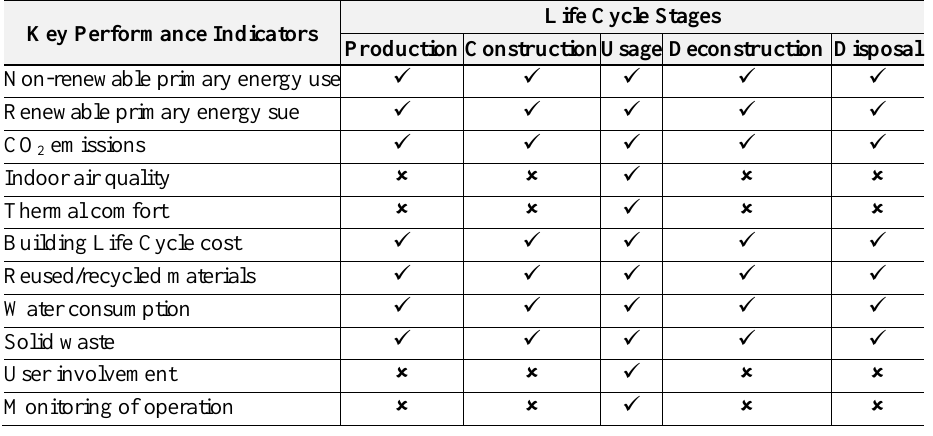
Table 2 – Reference of KPI recognition within building life cycle Key Performance